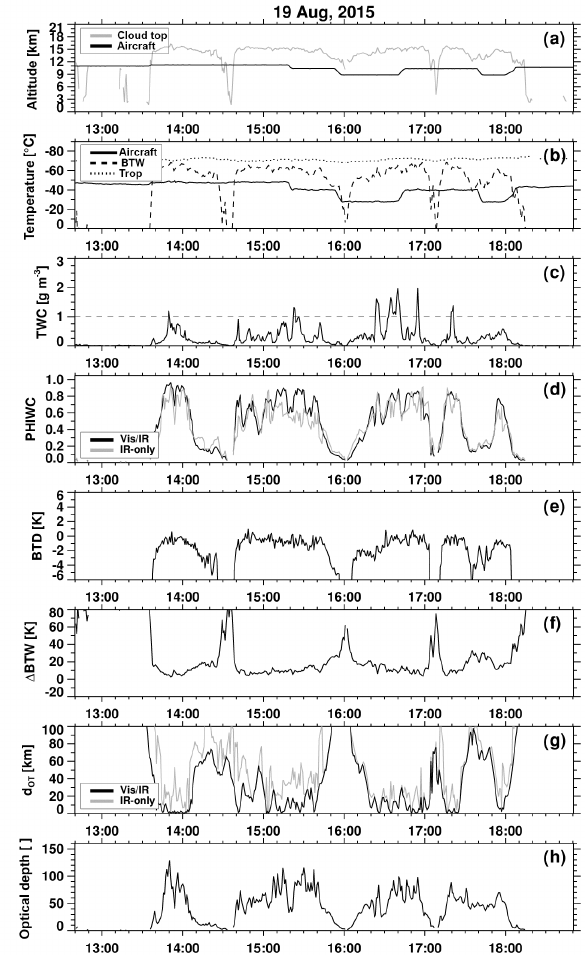
Figure 10. Time series of matched aircraft and satellite observations for Falcon 20 Flight 19 of Cayenne-2015. The panels are the same as those described for Fig. 4.